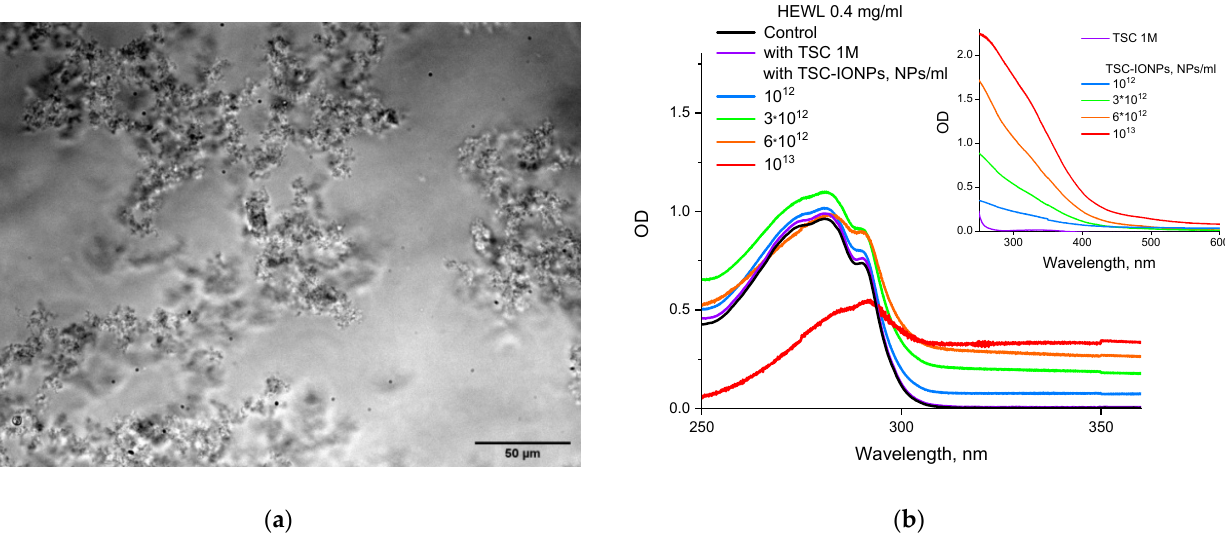
Figure 4. ( a ) Photo of aggregates of HEWL (5 mg/mL) and TSC-IONPs (10 13 mL − 1 ) made with a microscope. ( b ) Absorption of HEWL solution (0.4 mg/mL) with the addition of various concentrations of TSC-IONPs (up to 10 13 mL − 1 —red line) and TSC 1 M (purple line). Measurements were made relative to water for protein, or relative to the respective concentrations of TSC-IONPs and TSC. The top right inset shows absorption measurements of TSC-IONPs and TSC 1 M solutions concerning water.